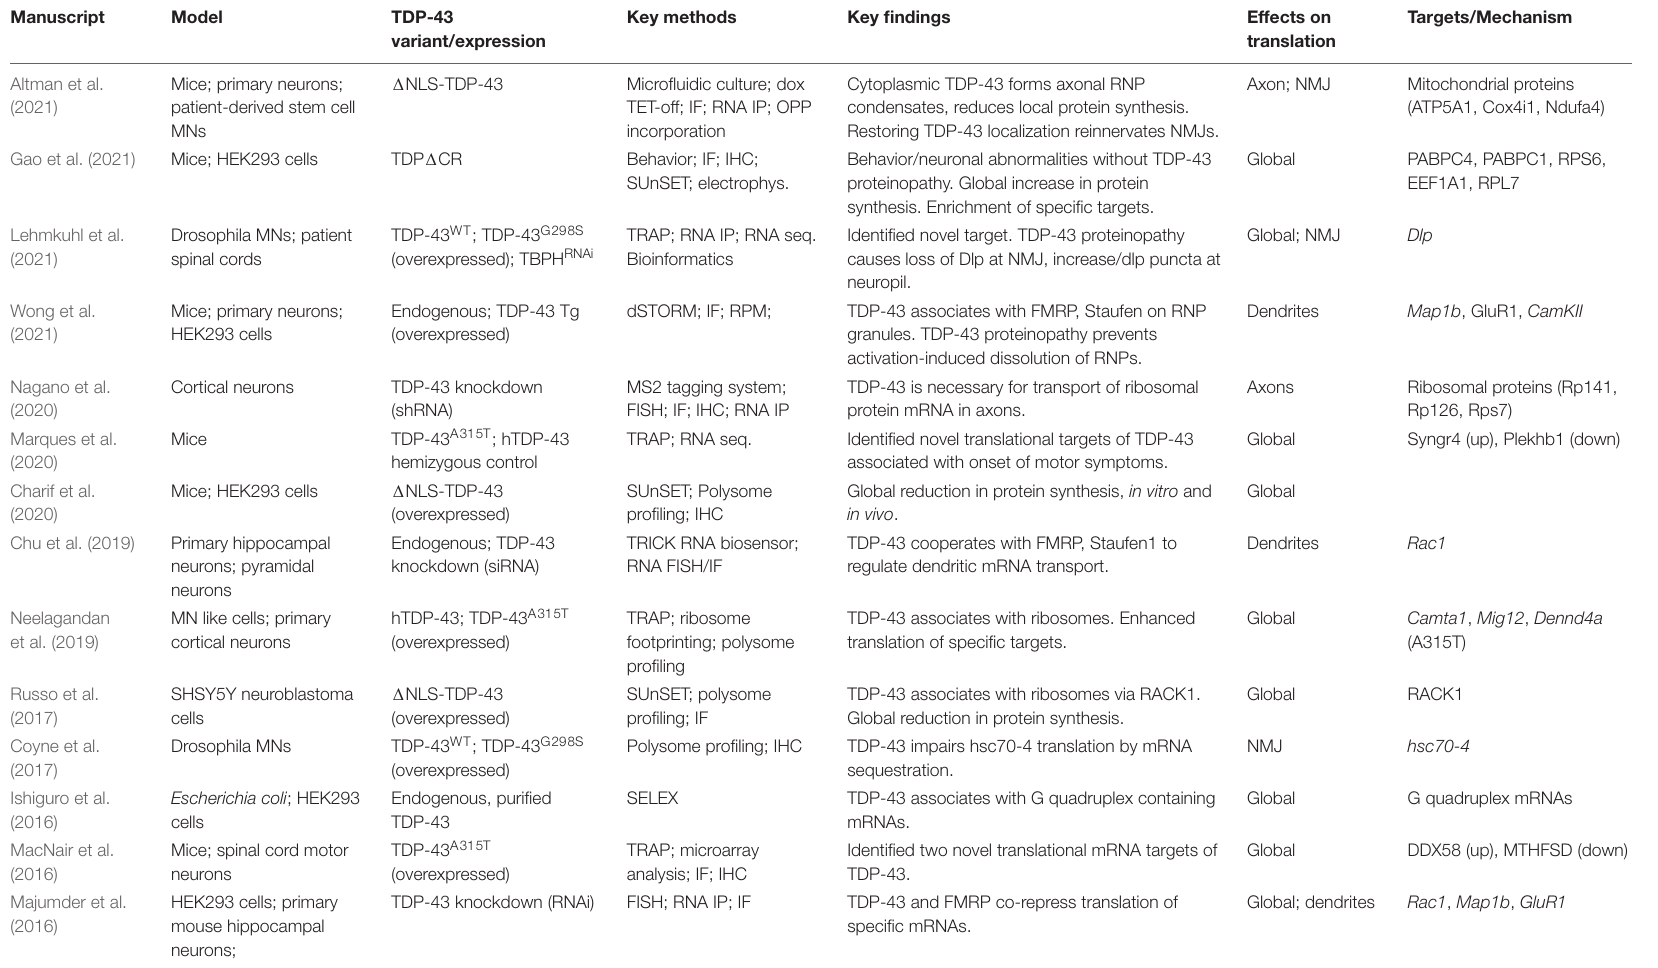
TABLE 1 | Summary of key findings on the role and mechanism of TDP-43 in regulating